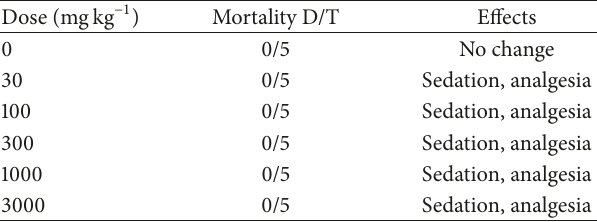
Table 1: Effects of Pseudospondias microcarpa hydroethanolic leaf extract in the primary observation test in rats.